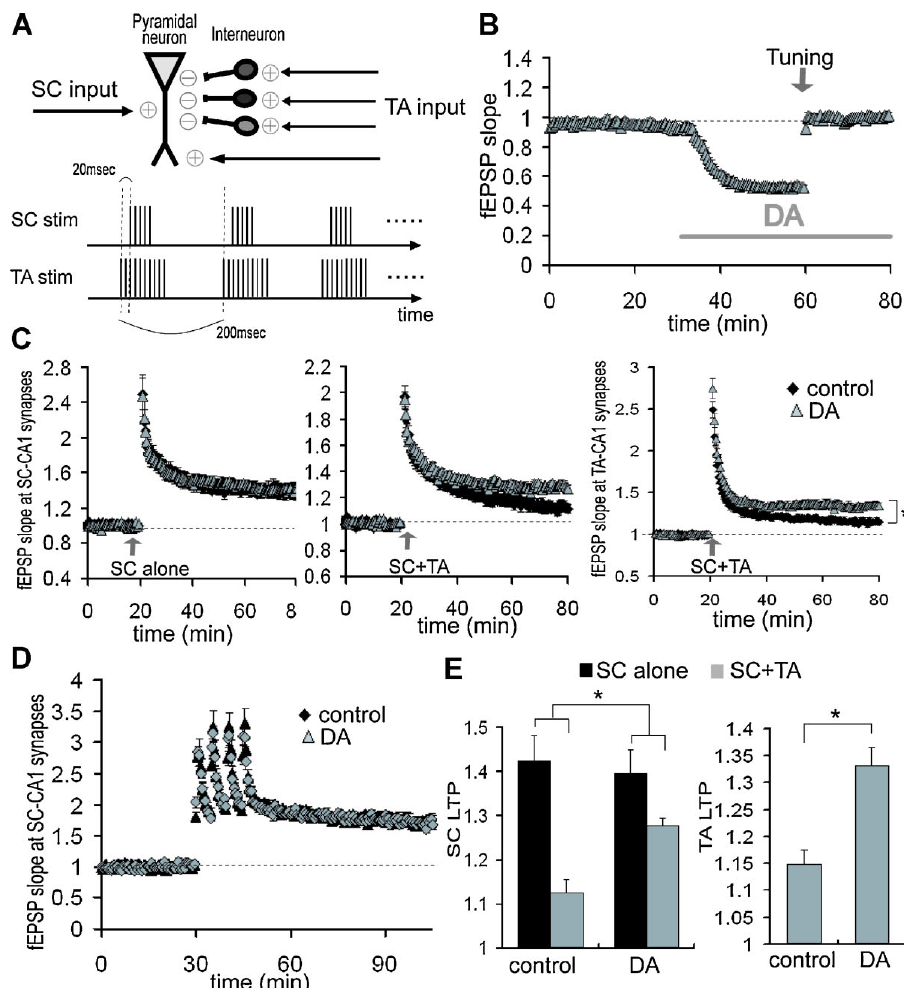
Figure 9. Reduction of LTP interference at SC-CA1 synapses by DA-induced disinhibition at TA-CA1 synapses . ( A ) Scheme of LTP interference protocol. Bursts (10) of either 5 (SC) or 10 (TA) at 100Hz with 200ms interburst interval, was repeated twice at 30second interval. TA-TBS precedes SC-TBS by 20ms. ( B ) Compensation of DA-induced excitatory depression by increasing the stimulation current. After DA-induced depression was stabilized, the stimulation current was increased to return the fEPSP to its baseline value (tuning, indicated by arrow). ( C ) Influence of DA on the LTP interference of SC- CA1 synapses elicited by the TA pathway stimulation. TBS was applied to either the SC pathway alone (left; control: n = 8, DA: n = 6) or both the SC and the TA pathways concurrently (middle; n = 9 for each group). Right figure shows the enhancement of LTP at TA-CA1 synapses by DA after concurrent TBS application (n = 9 for each group). ( D ) No significant influence of DA on SC-LTP induced by HFS. LTP induction protocol was 100Hz (100pulse) stimulation, repeated 4 times at 5minute intervals (n = 6 for each). ( E ) Analysis of DA’s effects on the magnitude of LTP after TBS application, either at SC-CA1 synapses (left) or at TA-CA1 synapses. DA significantly attenuated the LTP interference at SC-CA1 synapses (p<0.05), and enhanced LTP at TA-CA1 synapses